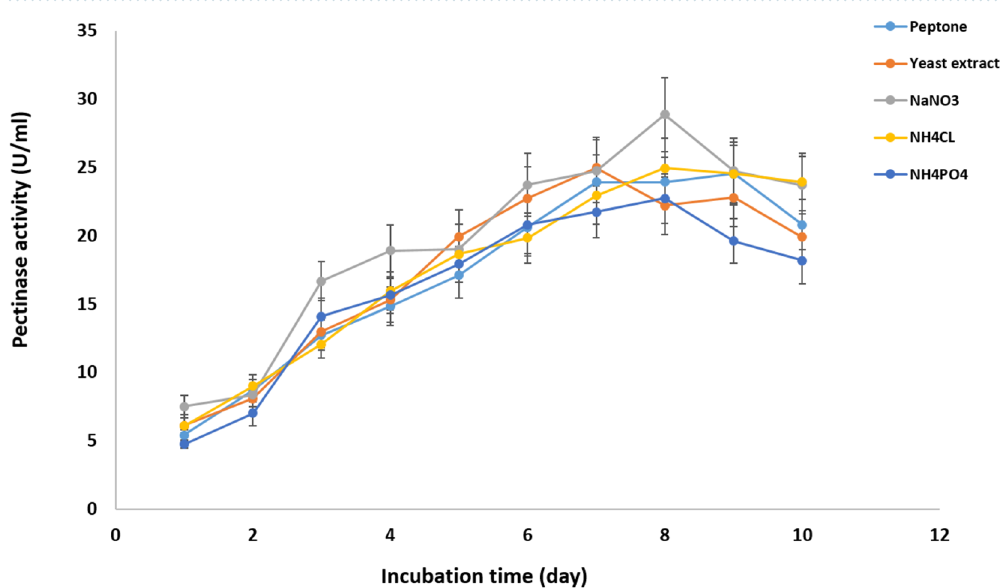
Figure 10. Effect of nitrogen source and incubation time on the pectinase production by C. parasphaerospermum AUMC 10865 at pH 6.0 and 10 °C after 8 days.